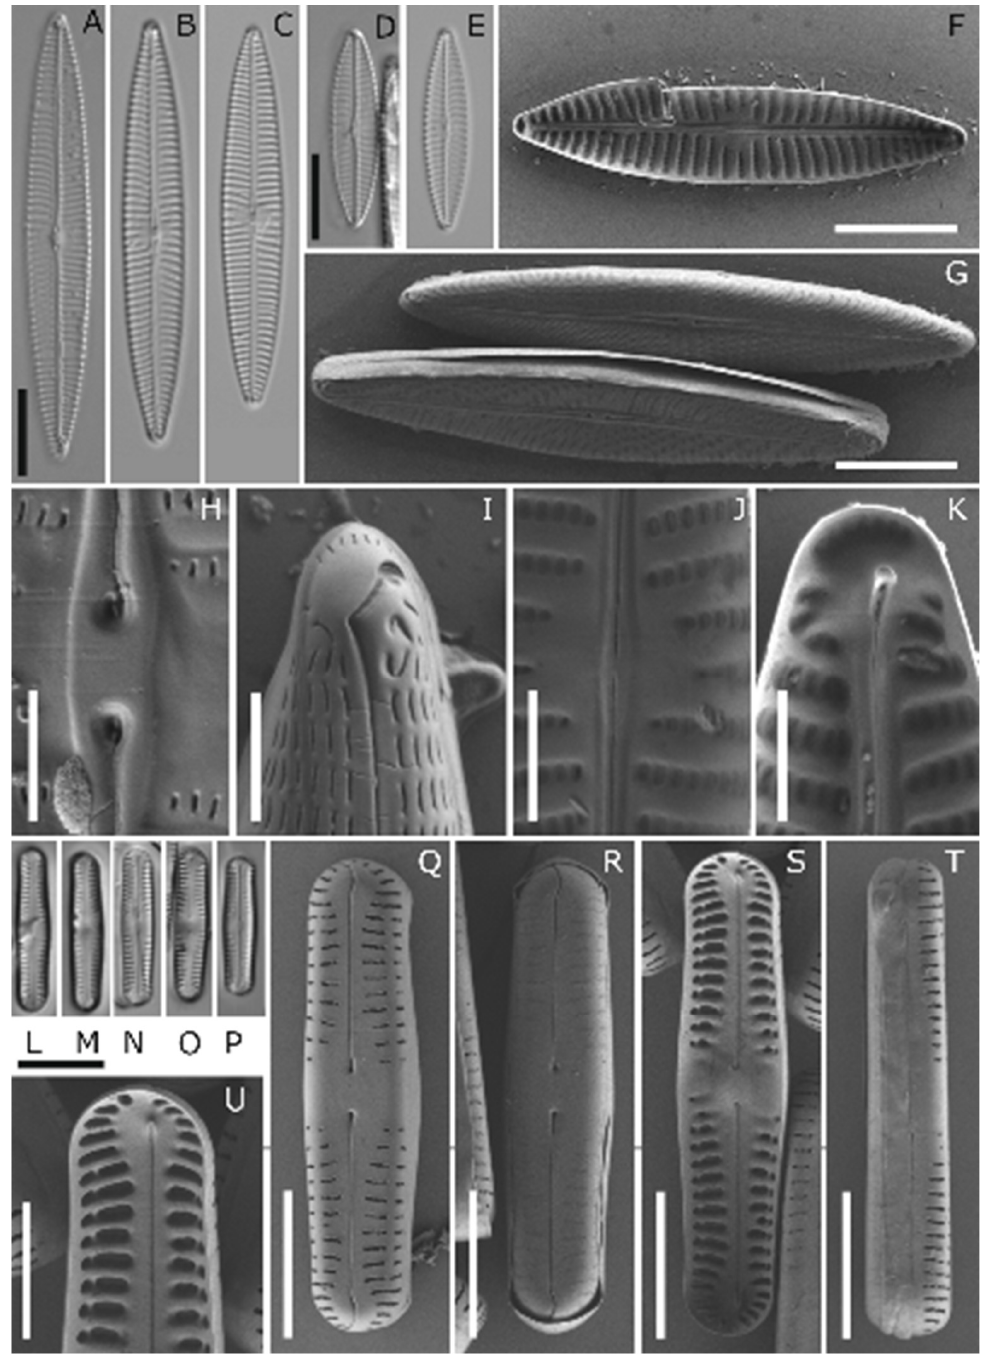
Figure 2. LM and SEM Image Set 1 ( A – U ): ( A – K ) Navicula criophiliforma . ( A – E ) LM pictures; de- velopment of auxospores led to size differences in the valves in the culture. ( F – K ) SEM pictures: ( F ) whole-valve internal view, ( G ) whole-valve external view, ( H ) external central raphe endings, ( I ) valve apex external view, ( J ) internal proximal raphe endings, ( K ) valve apex internal view. ( L – T ) Chamaepinnularia gerlachei , APC12 D294_006, and Chamaepinnularia gerlachei : ( L , M ) LM pictures of the strain Chamaepinnularia gerlachei , ( N – P ) LM pictures of the strain APC12 D294_006, ( Q – U ) SEM pictures of APC12 D294_006. ( Q , R ) whole-valve external view, hymenate occlusion of areolae partly corroded, ( S ) whole-valve internal view, ( T ) valve in girdle view, ( U ) valve apex internal view. Scale bars: ( A – G ) and ( L – P ) 10 µm, ( H – K ) and ( U ) 2 µm, and ( Q – T ) 5 µm.